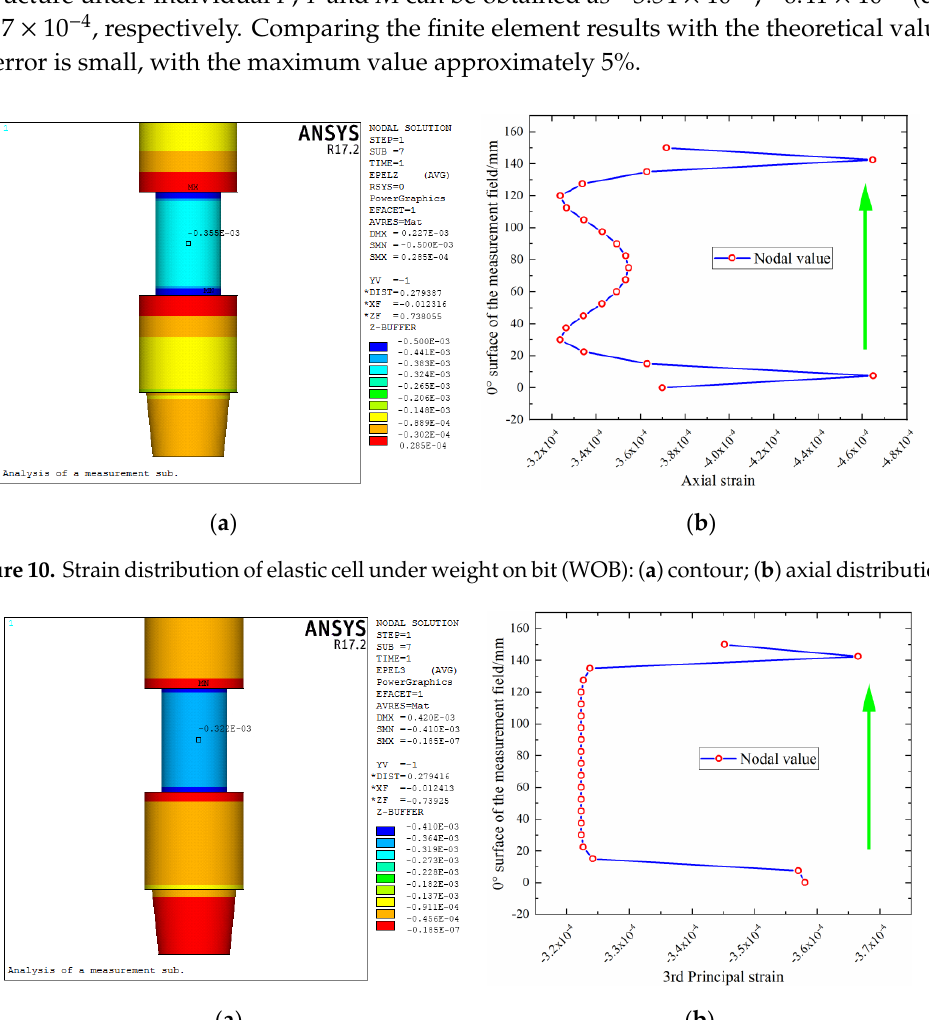
Figure 11. Strain distribution of elastic cell under torque: ( a ) contour; ( b ) axial distribution.